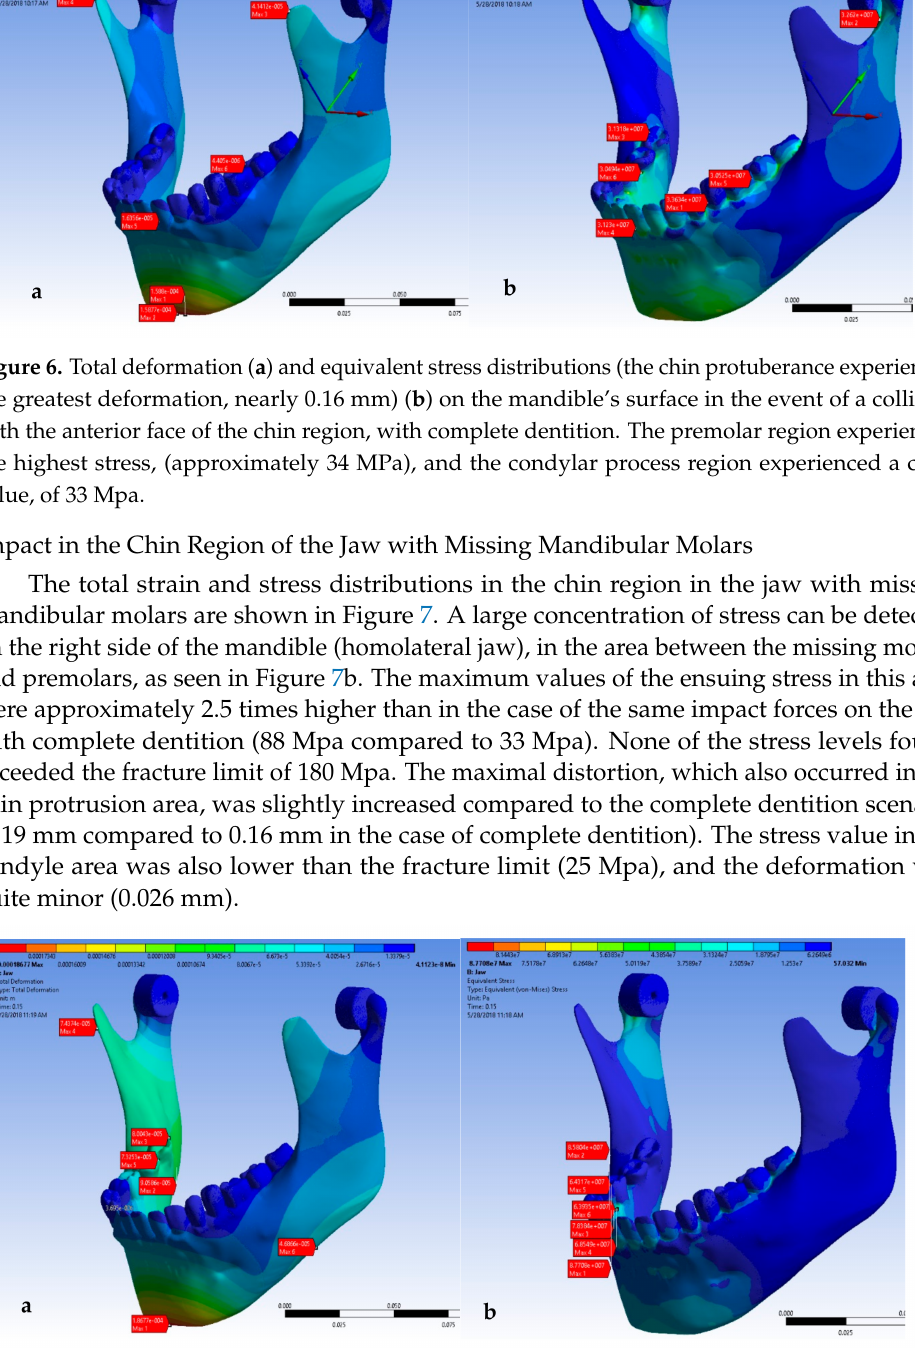
Figure 7. Distributions of total deformation ( a ) and equivalent stress ( b ) on the surface of the mandible in the event of an impact on the anterior face of the chin region in the absence of first, second, and third molars. The area of the mental protuberance showed the highest deformation, 0.19 mm. The condyle area had a stress value of 25 MPa and little deformation of 0.026